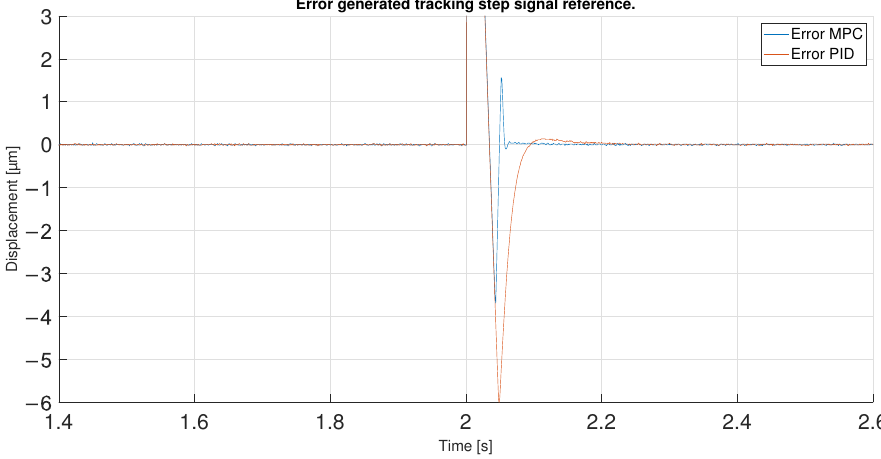
Figure 31. Zoom of error of tracking of the PID and MPC for a step